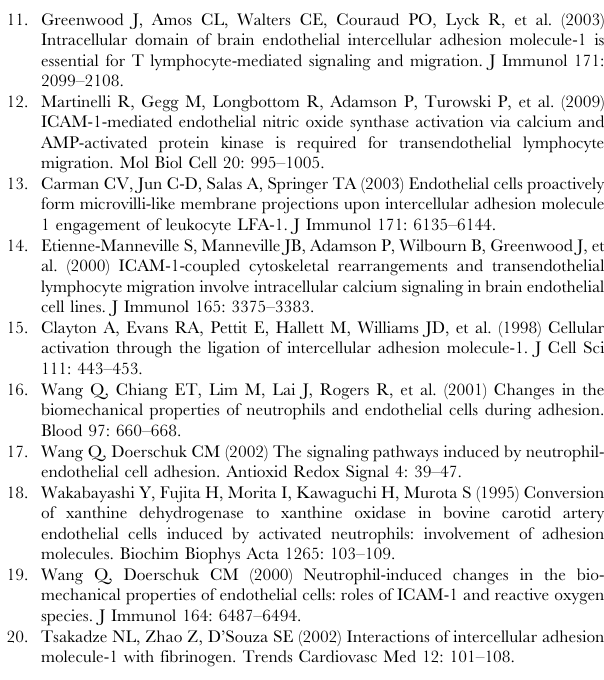
Figure 5. D- a -tocopherol inhibits ICAM-1-activated PKC a but not ERK1/2 in HMVECLs and the inhibition by d- a -tocopherol is abrogated by d- c -tocopherol. At 70% confluence, HMVECLs cells were pretreated with TNF a for 6hrs and then treated with tocopherols or the solvent control 0.01% DMSO for 16 hrs. A ) d- a -tocopherol ( a -toc) regulation of ICAM-1-stimulated PKC a Thr 638 phosphorylation (PKC a P-Thr 638 ). B ) d- c -tocopherol ( c -toc) regulation of ICAM-1-stimulated PKC a P-Thr 638 . C ) d- a -tocopherol + d- c -tocopherol regulation of ICAM-1-stimulated PKC a P- Thr 638 . D ) d- a -tocopherol does not alter background PKC a P-Thr 638 (no anti-ICAM-1). E ) d- a -tocopherol does not regulate ERK1/2 Thr 202 /Tyr 204 phosphorylation (P-ERK1/2). F ) d- c -tocopherol does not regulate ERK1/2 Thr 202 /Tyr 204 phosphorylation. Shown are the means 6 SEM from 3 experiments. *, p , 0.05 as compared with the anti-ICAM-1-stimulated groups.